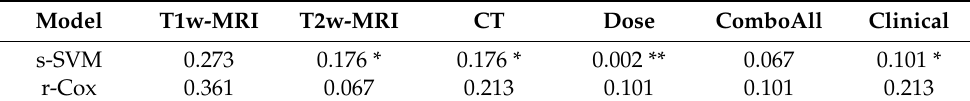
Table 3. Log-rank tests were applied to statistically describe differences between survival curves for patients at high- and low-risk of meeting an adverse local control for the best cases of each modality (i.e., T1w-MRI, T2w-MRI, CT, dose, clinical) and their combination (comboAll), for both s-SVM and r-Cox models. Cases in which the p -value pointed to a statistically significant separation ( α = 0.0083) in the re-training set are marked with *, whereas ** marks cases in which significance was found in both re-training and test sets.